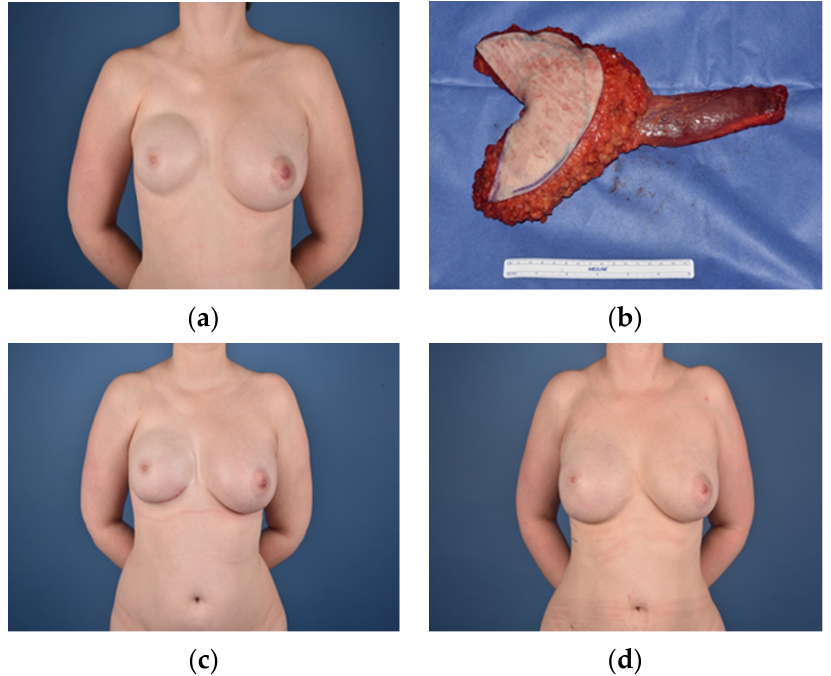
Figure 3. ( a ) = Female patient (27) pre-operatively with Grade II deformity and previous implant- based reconstruction; ( b ) = TMG flap before anastomosis; ( c ) = Recipient site 6 weeks after flap reconstruction; ( d ) = Recipient site 29 months after flap reconstruction and 4× autologous free fat transfer (720 mL total).